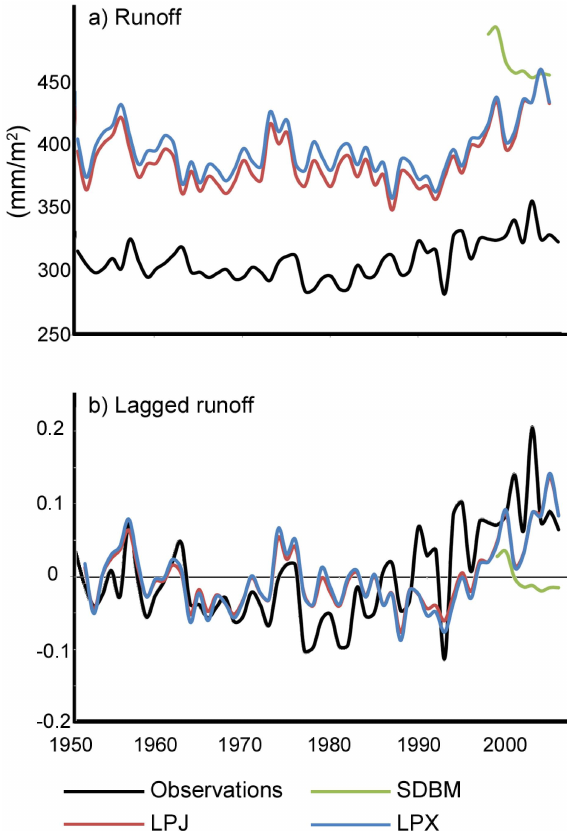
Fig. 8. Observed inter-annual runoff for 1950–2005 averaged over basins from the Dai et al. (2009) dataset (black line) compared to av- erage simulated runoff over the same basins from LPJ (red line) and LPX (blue line). (a) shows inter-annual runoff, and (b) shows inter- annual variability in runoff where the simulated values are lagged by a